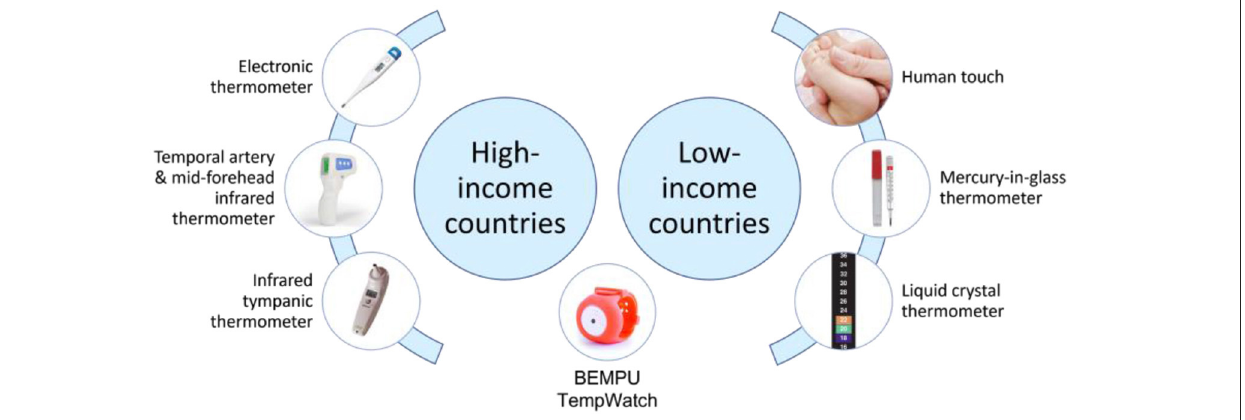
FIGURE 1 | Temperature monitoring devices currently available for use in